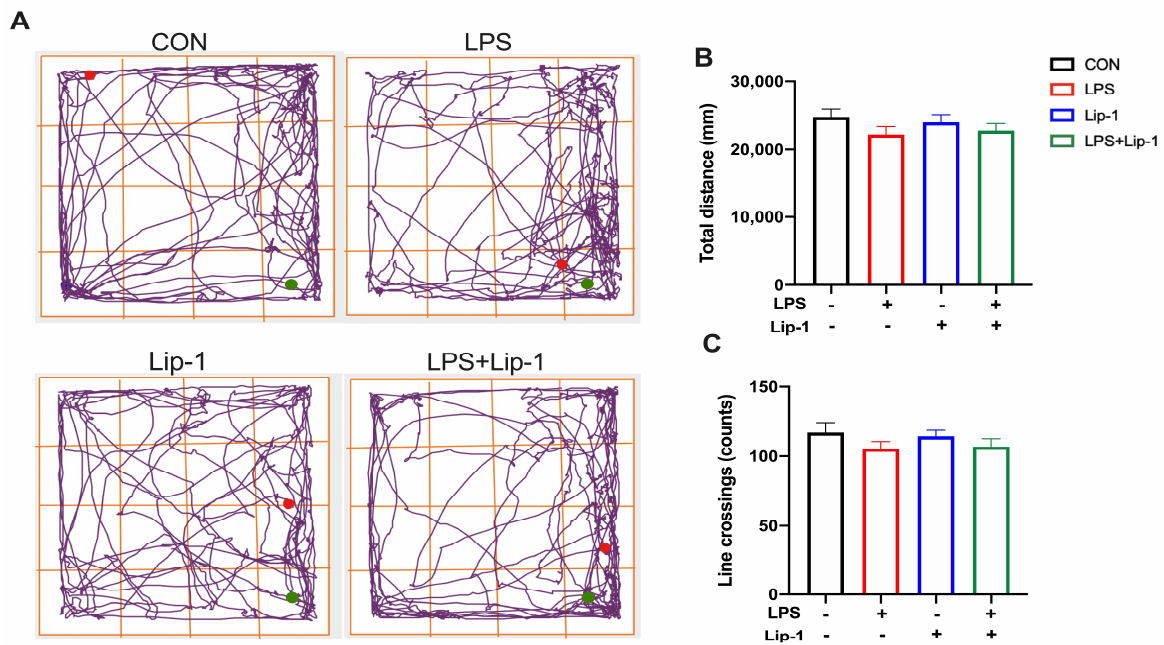
Figure 1. LPS and liproxstatin-1 did not affect the spontaneous activity of mice in the open field test. ( A ) Representative moving trajectories of mice in the open arena during the 8 min. The green spot presents the start of mice movement, and the red spot presents the end. ( B ) Total distance, ( C ) line crossings are expressed as mean ± SE ( n = 12).